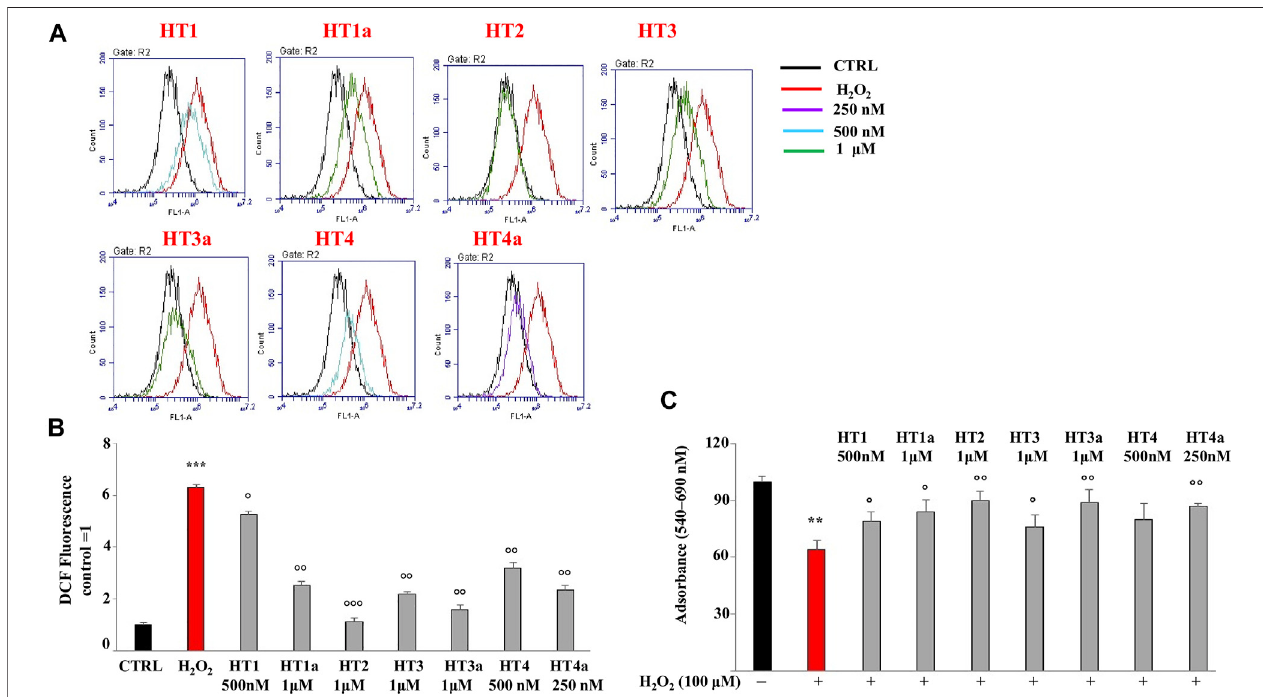
FIGURE 5 | Evaluation of ROS accumulation. (A) Protective effects of target compounds concentration against H 2 O 2 -induced injury in SH-SY5Y cells. The most effective concentrations were chosen. The results obtained from the cytometric analysis were displayed as overlays of the individual plots. (B ) Relative quanti fi cation of ROS accumulation. The control value was arbitrarily set to 1 and all other values were related to it. A representative result of three independent experiments (which reported the same results) is shown. Values are expressed as the mean ± standard deviation. *** p < 0.001 vs. the control. ° p < 0.05 vs. hydrogen peroxide;